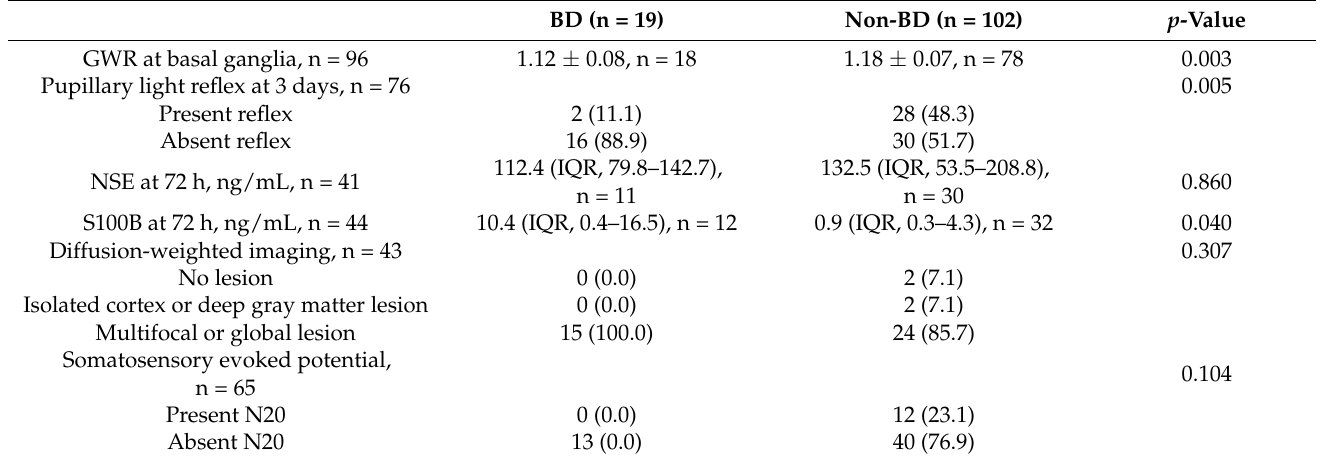
Table 2. Contingency table depicting the relationship between various outcome predictors and the occurrence of BD.